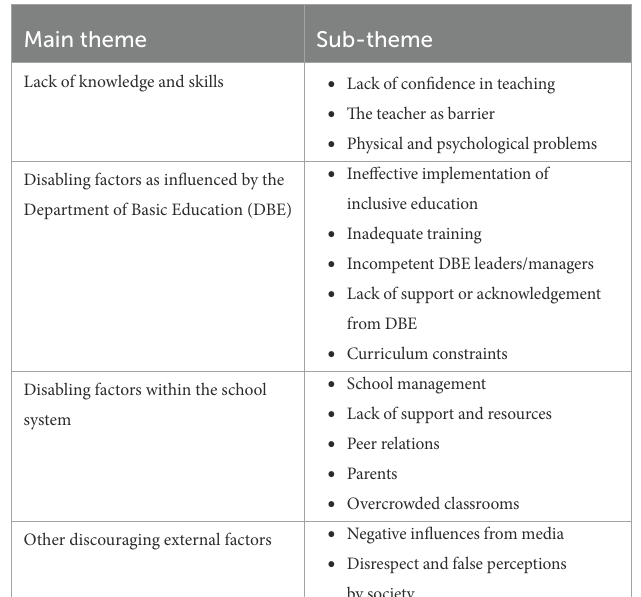
TABLE 1 Summary of categories, themes and